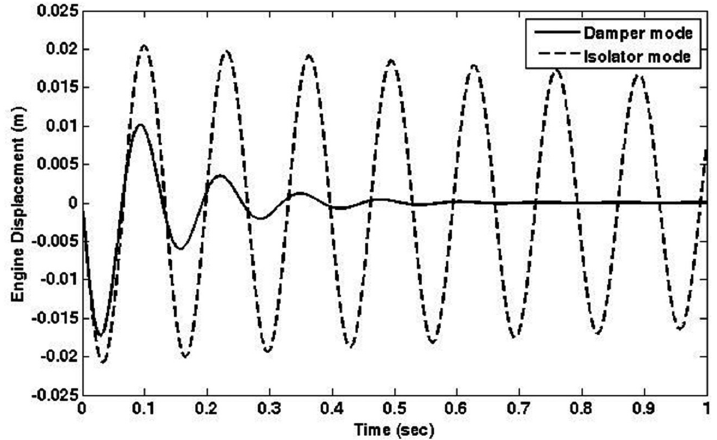
Fig. 10. Engine displacement with respect to an initial velocity of